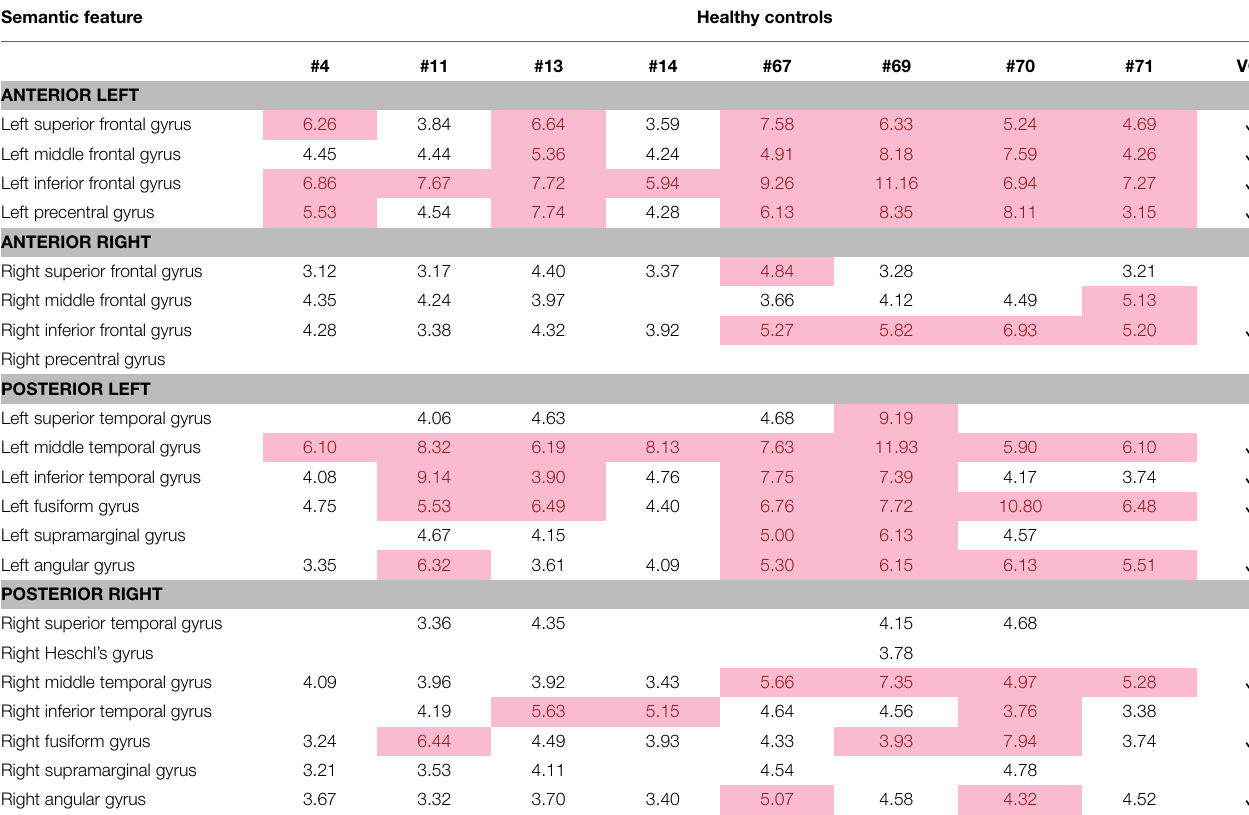
TABLE 5 | Regions of activation across healthy control participants at one time point with T -values for semantic feature verification task. Semantic